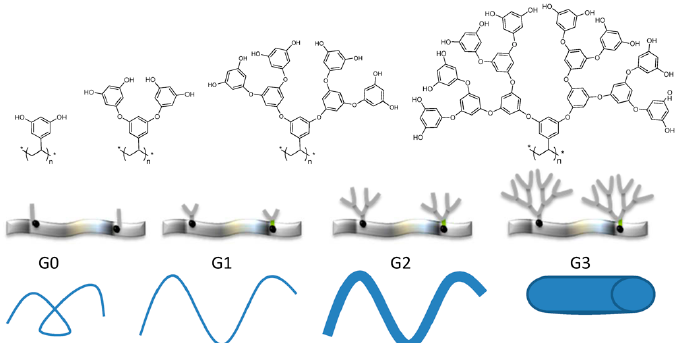
Figure 3. Scheme showing the variation of the structural flexibility of a dendronized polymer as a function of dendron generation (G0 to G3). Reproduced from Julieta I. Paez et al. [3].